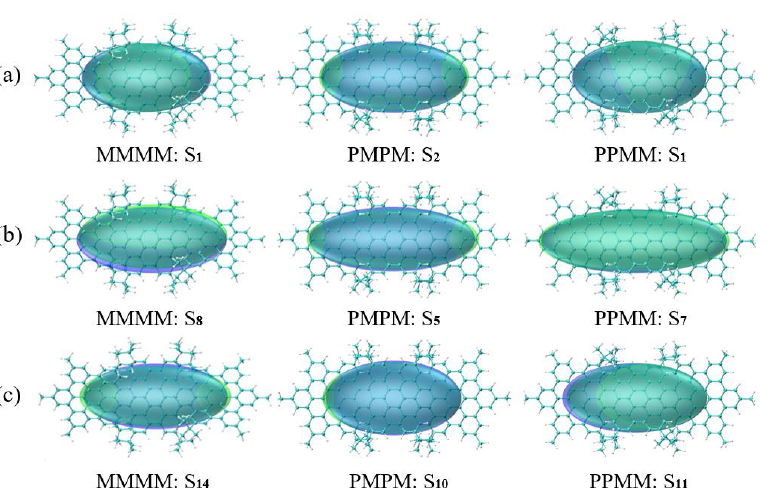
Figure 6. The hole-electron smooth distribution diagram of excited states of three isomeric molecules. The green isosurface represents electrons, and the blue isosurface represents holes. ( a ) The hole-electron smooth distribution diagram of the excited states of three isomeric molecules at 390–500 nm in the spectrum (There are S1 of MMMM at 477 nm, S2 of PMPM at 428 nm and S1 of PPMM at 472 nm, respectively); ( b ) The hole-electron smooth distribution diagram of the excited state corresponding to the strong peak are S8 of MMMM, S5 of PMPM and S7 of PPMM, respectively; ( c ) The hole-electron smooth distribution diagram of the excited state corresponding to the sub-strong peak are S14 of MMMM, S10 of PMPM and S11 of PPMM,